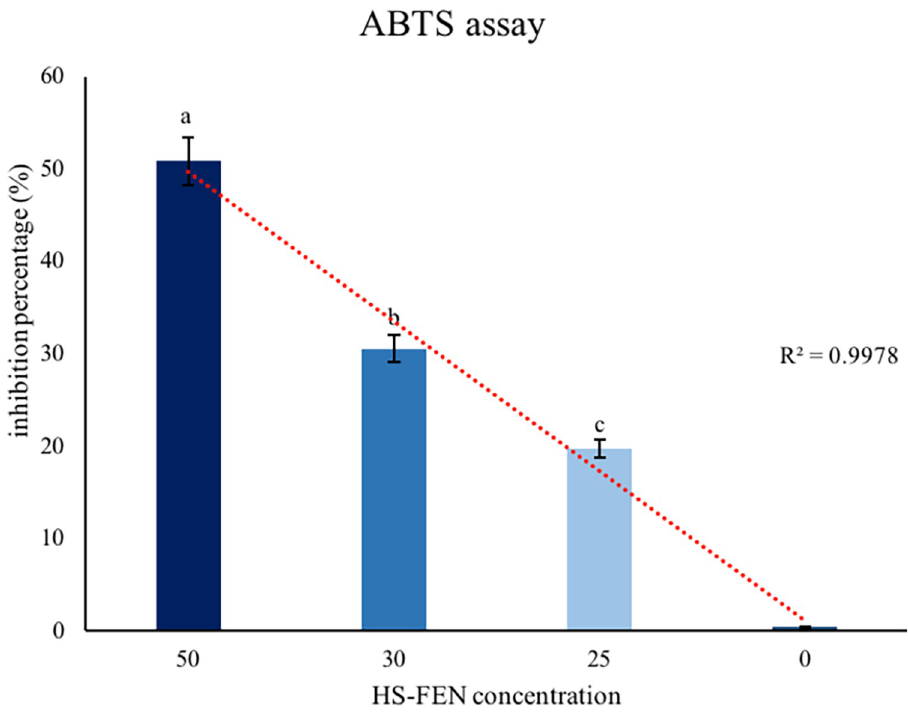
Fig 4. Antioxidant activity of HS-FEN at different concentration (50, 30, 25 μ g mL -1 ). Vertical bars represent the standard deviation (s.d.). Different capital letters indicate significant differences according to Tukey test ( p � 0.05).